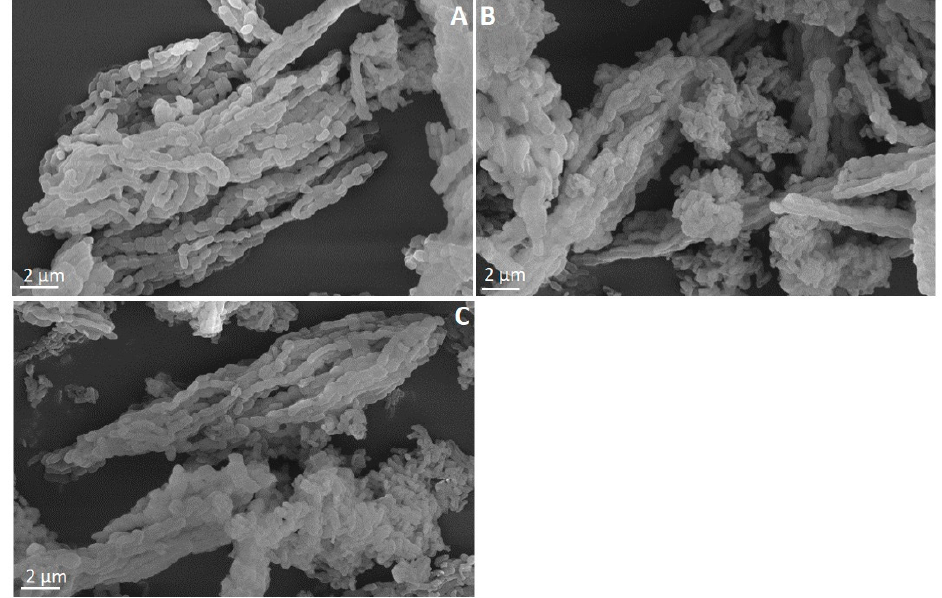
Figure 5. SEM images of ( A ) SBA-15-pr-NH 2 , ( B ) SBA-15-pr-NH 2 :PBZ, and ( C )